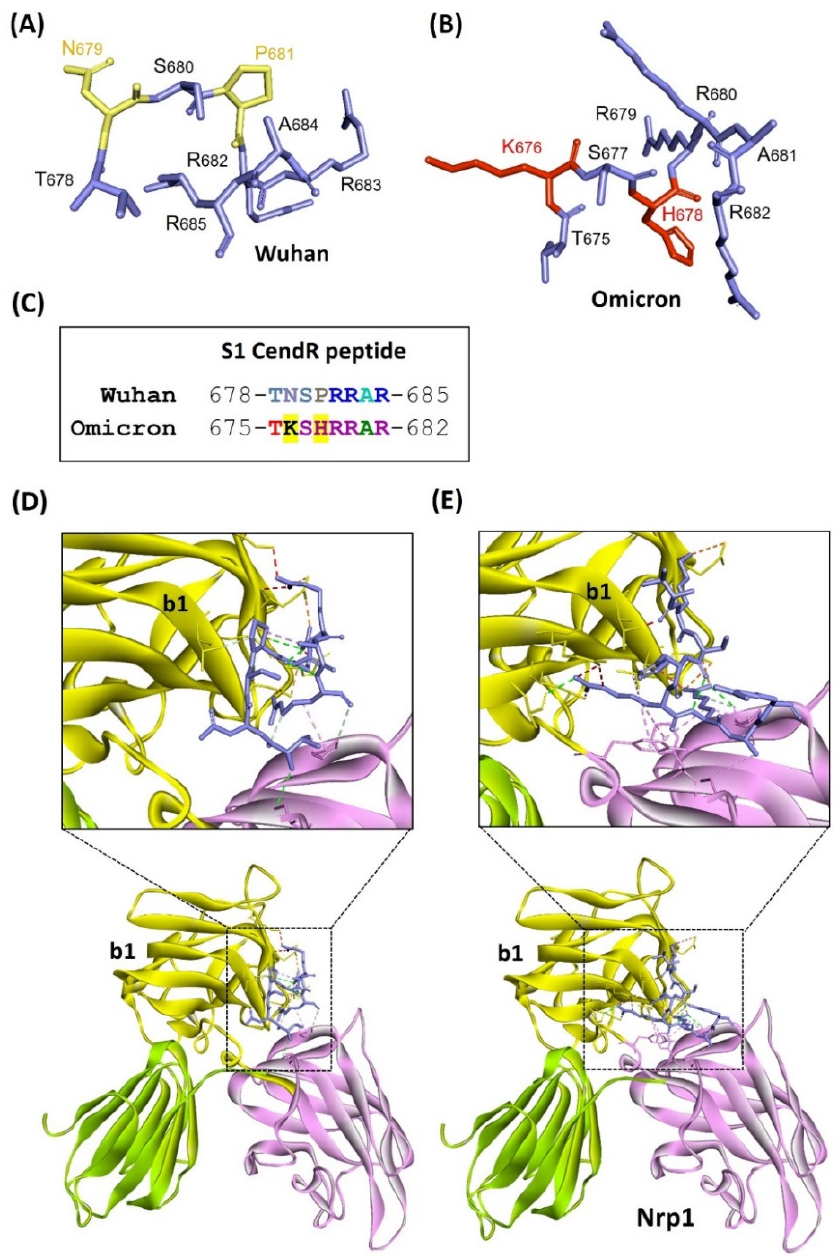
Figure 2. Homology modeling, sequence analysis for variant amino acids, and molecular docking analysis of CendR motif of original Wuhan isolate or Omicron variant with Nrp1. ( A ) CendR motif of original Wuhan isolate of SARS-CoV-2. ( B ) CendR motif of Omicron with amino acids that are altered with respect to the original Wuhan variant shown in red. ( C ) Sequence alignment of CendR motifs from the original Wuhan isolate versus Omicron variant with amino acid alterations highlighted in yellow. ( D ) Nrp1 docking with CendR motif of original Wuhan isolate. ( E ) Nrp1 docking with CendR motif of Omicron variant. Interactions are shown in the zoomed image while the b1 domain (yellow color) contains the interaction site for the CendR motifs. Table 1. Determination of free binding energy (kcal/mol) from the docking analysis of Omicron, Delta, and Wuhan variant CendR with Nrp1.